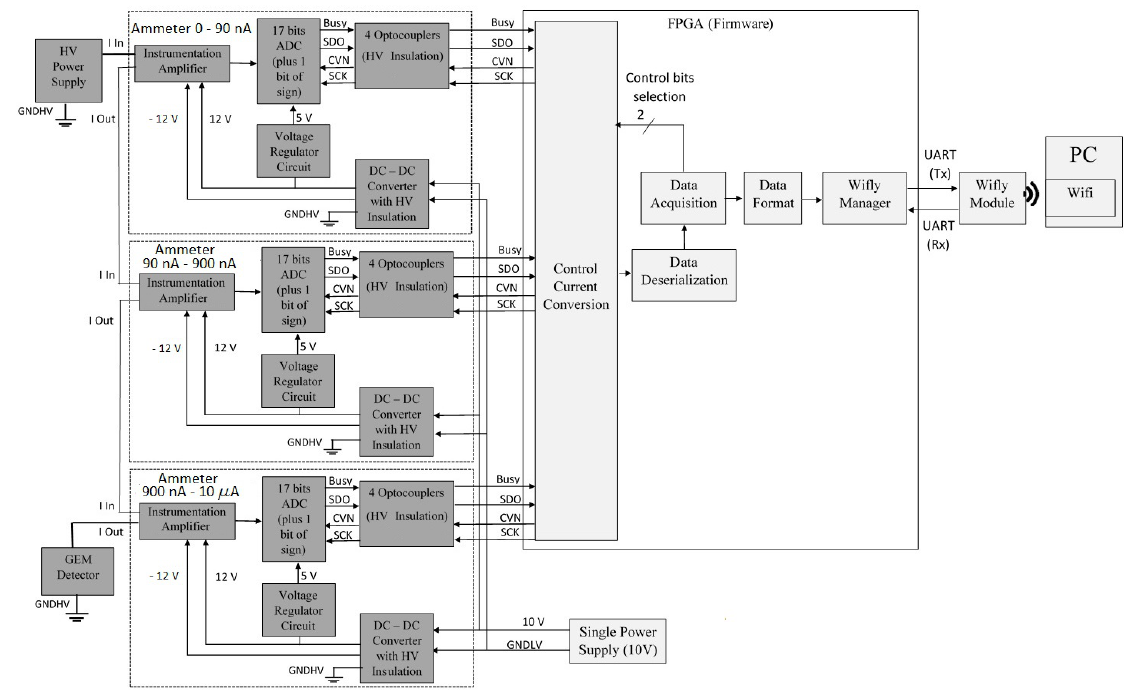
Figure 1. Block diagram of the current monitor.